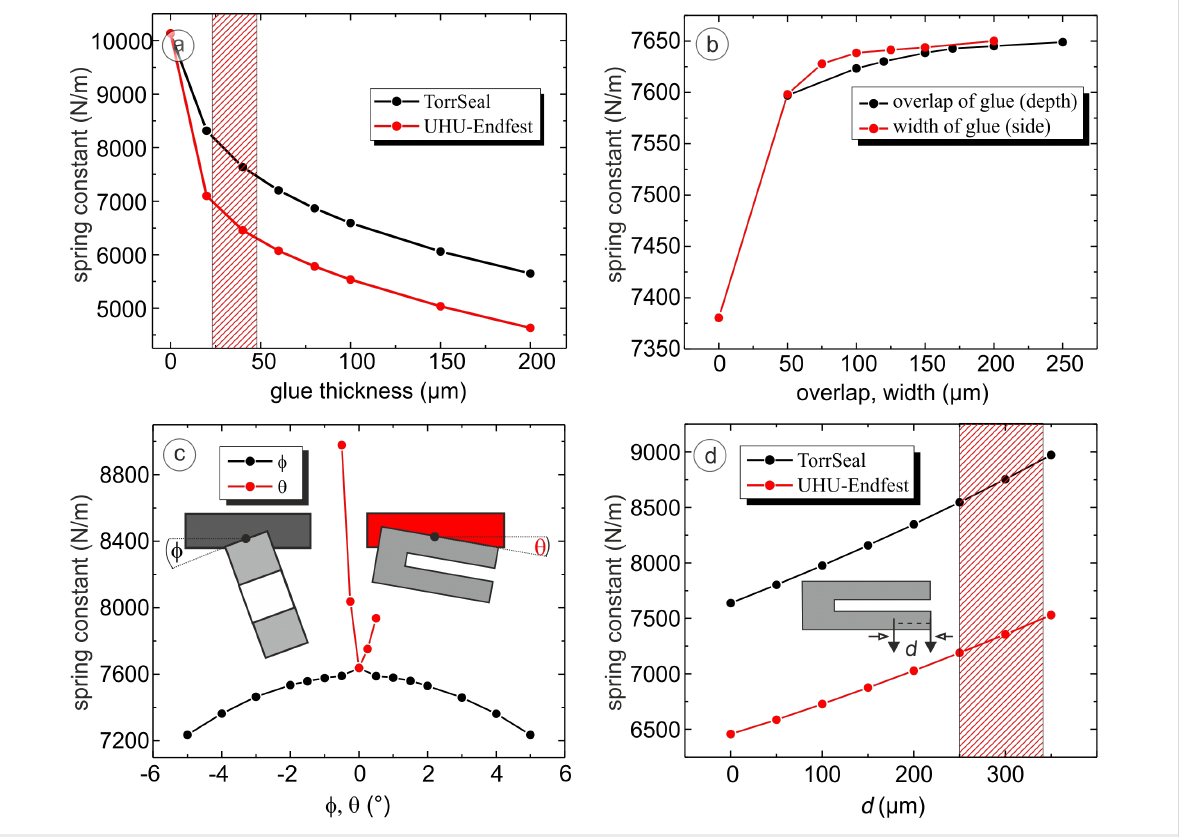
Figure 7: Results of the FEM simulations, when one parameter is varied. The standard parameters are thickness t = 0.04 mm, overlap o = 0.15 mm, width w = 0.1 mm, Φ = 0°, and θ = 0°. The parameters that are not varied are set to the standard values. (a) Spring constant with Torr Seal (black) or UHU endfest (red) as a function of the glue thickness. The hatched area marks the experimental range. (b) Spring constant as a function of the overlap and width of the glue enclosing the upper prong of the tuning fork. (c) Spring constant versus Φ (red) and versus θ (black). While the spring constant decreases symmetrically as a function of Φ , it is asymmetric as a function of θ . (d) Spring constant as a function of the point at which the force was applied for Torr Seal (black) and UHU endfest (red). The shaded area displays the experimental